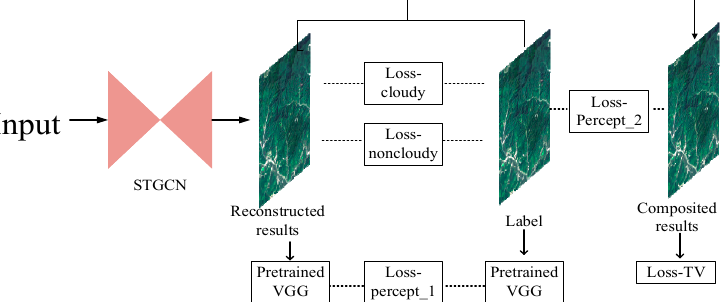
Figure 4. Joint loss that consists of an image-level, a feature level, and a total variation constraint. The image-level constraint includes the loss inside (loss-cloudy) and outside (loss-noncloudy) the cloudy region, the feature-level constraint consists of two perceptual